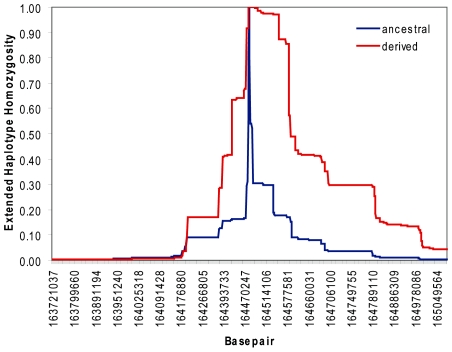
Haplotype decay around rs11724320 in 864 Caucasians from the Netherlands.Extended haplotype homozygosity and distance from core region rs11724320 in GWAS data with the derived allele shown in red and the ancestral allele in blue. For this analysis we used the derived and ancestral haplotypes of 864 Caucasians from the Netherlands. Although the derived C allele is very common in this population (allele frequency of 63%), it has long-range LD. This implies that the allele frequency increased rapidly in the population over a short time span.